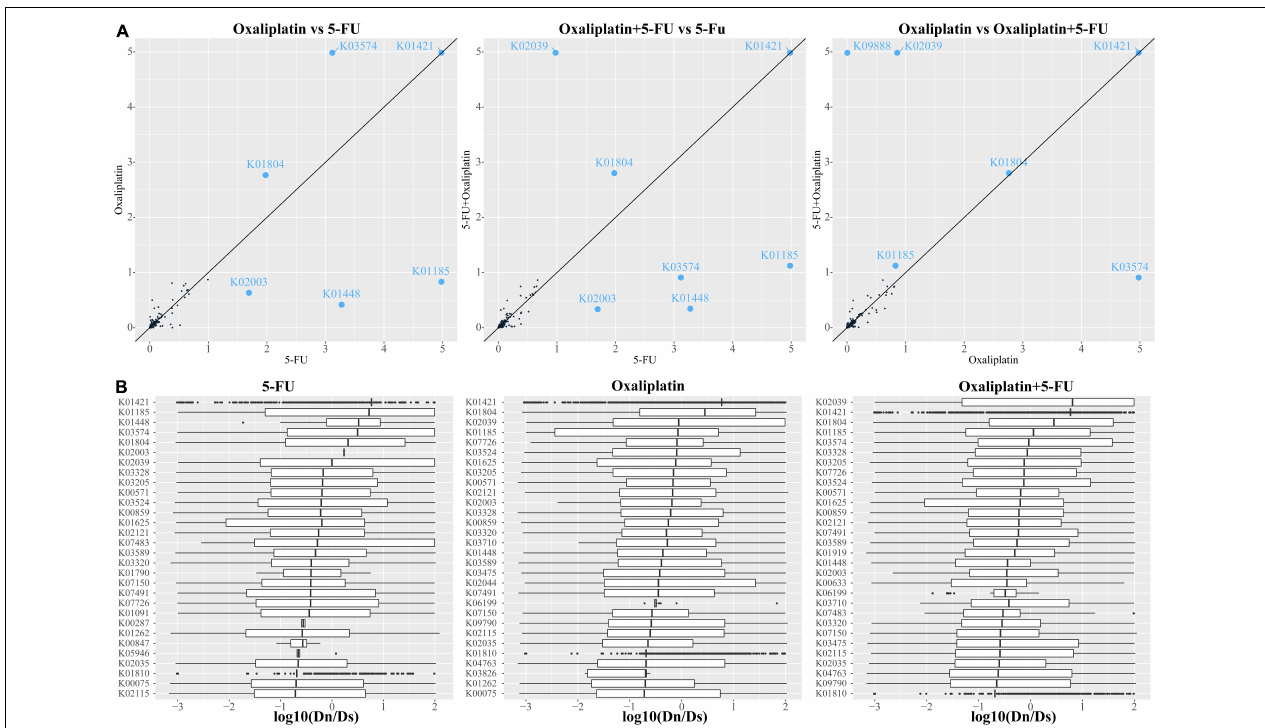
FIGURE 4 | KEGG modules under positive selection in different chemotherapeutic drugs. (A) The correlation of average Dn/Ds ratio of all KO modules between the drugs. KO modules with average Dn/Ds ratio larger than 1 were marked by blue points. Maximum ratio was limited at 5. (B) Boxplot of top 20 ranked KO modules under positive selection with significantly increased Dn/Ds statistic, with sorted by their median log transformed Dn/Ds in descending order. The row stand for different KO